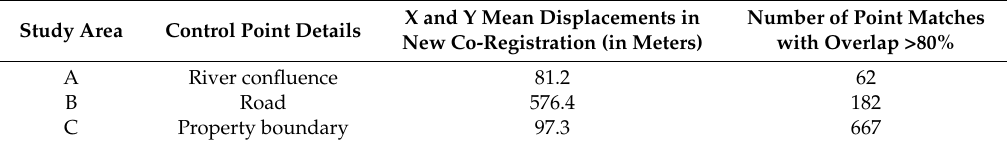
Table 2. Acquisition parameters of the used images.